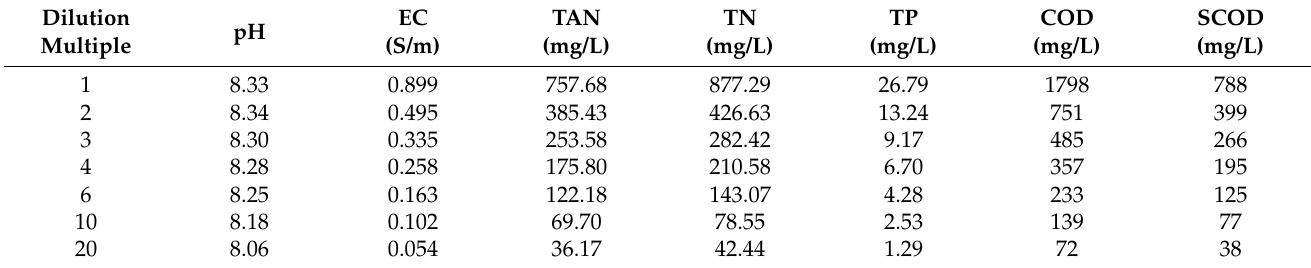
Table 2. Dilution gradient and concentration of fermented sanitation